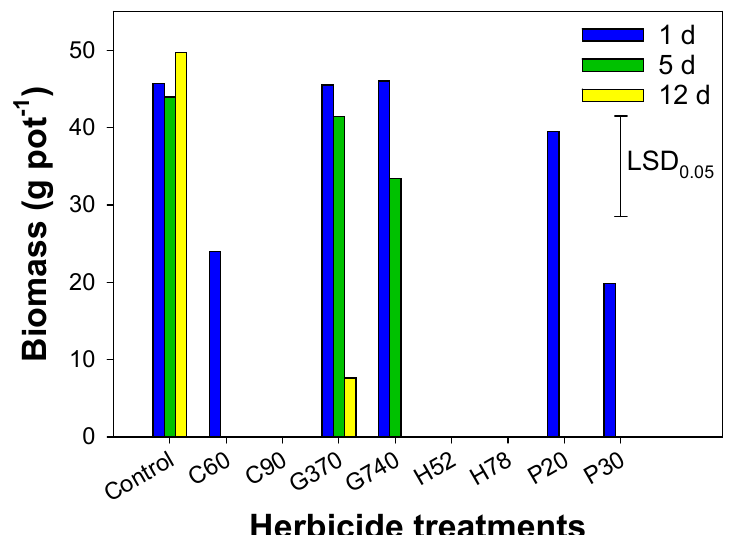
Figure 2. The interaction effect of herbicide (nontreated control; C60, clethodim 60 g a.i. ha − 1 ; C90, clethodim 90 g a.i. ha − 1 ; G370, glyphosate 370 g a.e. ha − 1 ; G740. Glyphosate 740 g a.e. ha − 1 ; H52, haloxyfop 52 g a.i. ha − 1 ; H78, haloxyfop 78 g a.i. ha − 1 ; P20, pinoxaden 20 g a.i. ha − 1 ; and P30, pinoxaden 30 g a.i. ha − 1 ) and their application timing (1, 5, and 12 d after grazing) on the aboveground biomass (g pot − 1 ) of Avena fatua .